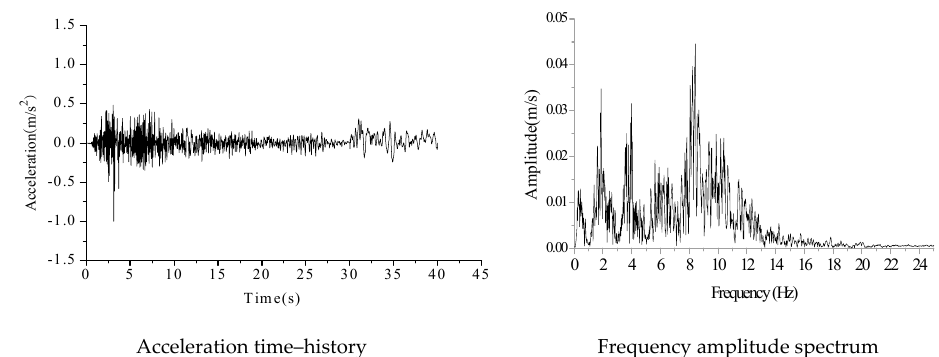
Figure 10. El-Centro motion in the vertical direction after inversion. Appl. Sci. 2017 , 7 , 1044